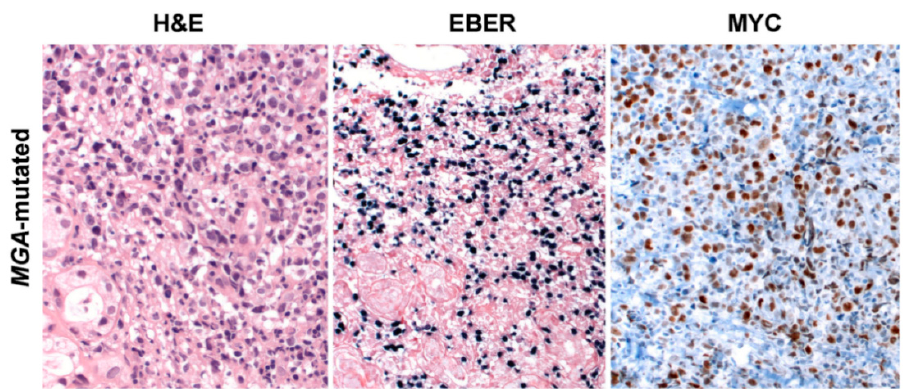
11 of 20 Figure 3. JAK-STAT signaling pathway and immune response evasion disturbances in ENKTCL. NKTCL biopsy carrying STAT3 activating mutation (c.1919A>T, p. Y640F) belonging to the tumor